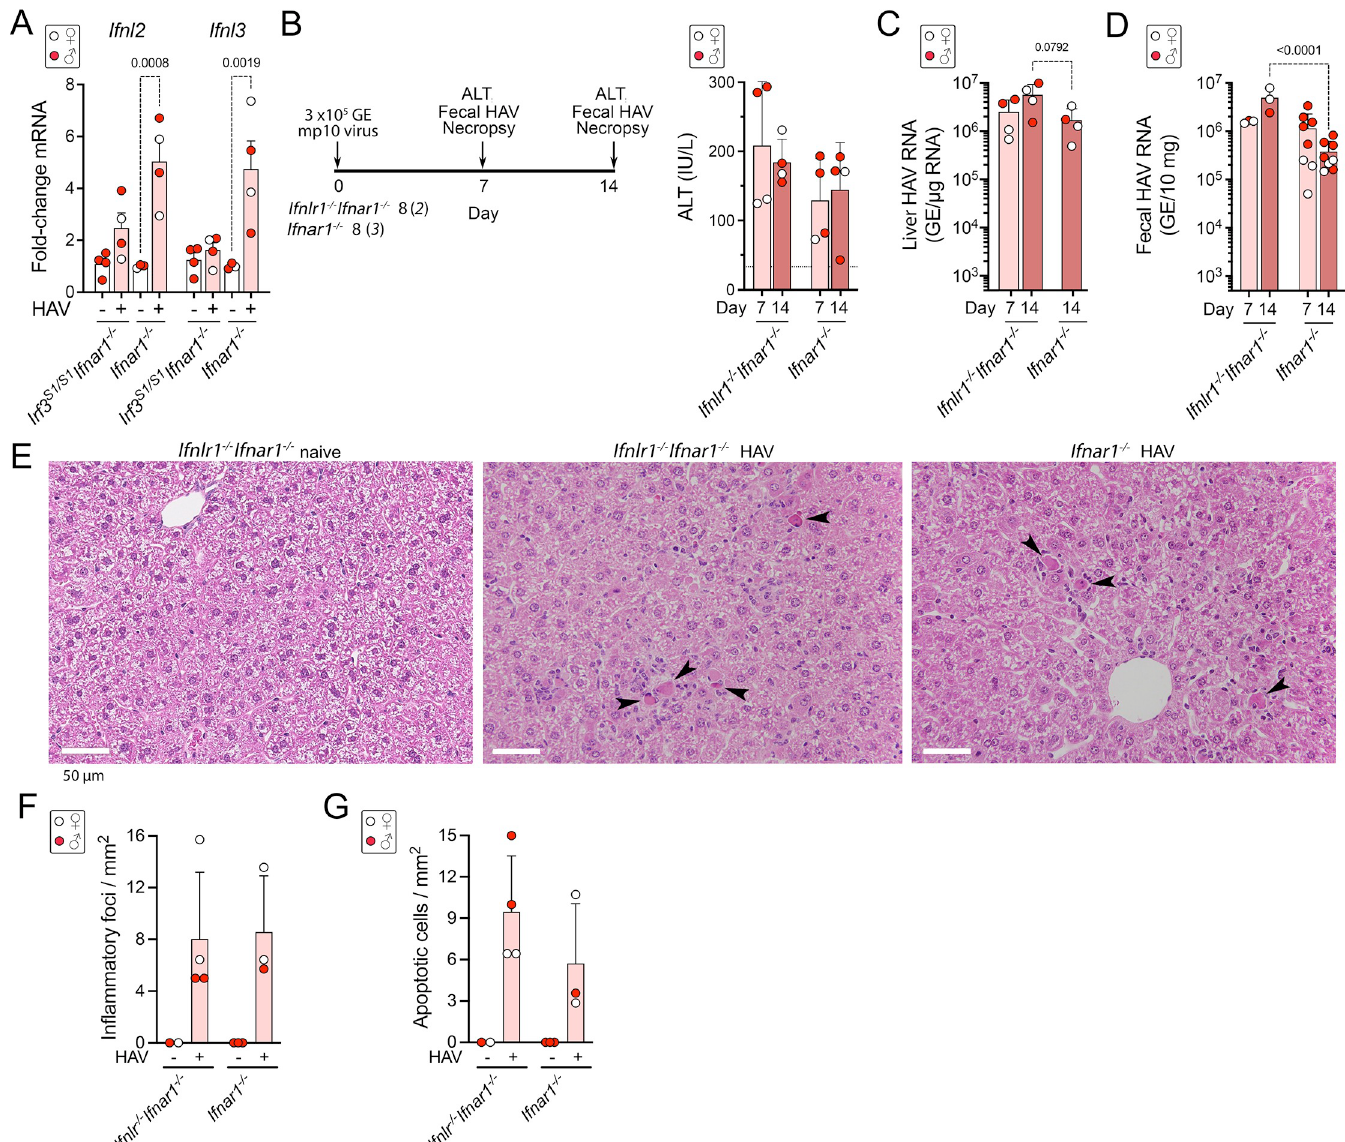
Fig 6. HAV infection in Ifnlr1 -/- Ifnar1 -/- double-knockout mice lacking receptors to both type I and III interferon. (A) Infection-induced changes in Ifnl2 and Ifnl3 transcript abundance in Irf3 S1/S1 Ifnar1 -/- and Ifnar1 -/- mice determined by RT-qPCR in the experiment outlined in Fig 3A. In all panels, male animals are indicated by solid red symbols, and female animals by open symbols. (B) ( left ) Experimental scheme and ( right ) mean serum alanine transaminase (ALT) activities in sera of Ifnlr1 -/- Ifnar1 -/- and Ifnar1 -/- mice 7 and 14 days after i.v. inoculation (dpi) of the 3 x10 5 GE (genome equivalents) HM175-mp10 virus. In each group, 4 infected animals were necropsied on day 7, and 4 on day 14 dpi. (C) Mean HAV RNA abundance in liver tissue and (D) feces determined by RT-qPCR. Fecal samples from additional Ifnar1 -/- mice infected with the same inoculum were included to demonstrate the range of fecal shedding in these animals. GE = genome equivalents. (E) Representative H&E stained sections of liver from HAV-na ï ve and infected mice 14 dpi. Arrowheads indicate apoptotic hepatocytes, many surrounded by inflammatory immune cells. ( F) Number of inflammatory foci and (G) apoptotic hepatocytes per mm 2 in H&E-stained liver sections at 14 dpi. Error bars in all panels are s.d. elevations were comparable in the two types of mice at days 7 and 14 p.i. ( Fig 6B ), but HAV RNA levels in both liver and feces were significantly greater in the Ifnlr1 -/- Ifnar1 -/- mice than Ifnar1 -/- mice on day 14 post-infection ( Fig 6C and 6D ). Histopathologic examination revealed similar numbers of apoptotic hepatocytes and similar inflammatory infiltrates in the infected Ifnlr1 -/- Ifnar1 -/- and Ifnar1 -/- mice ( Fig 6E and 6G ). Thus, while the additional absence